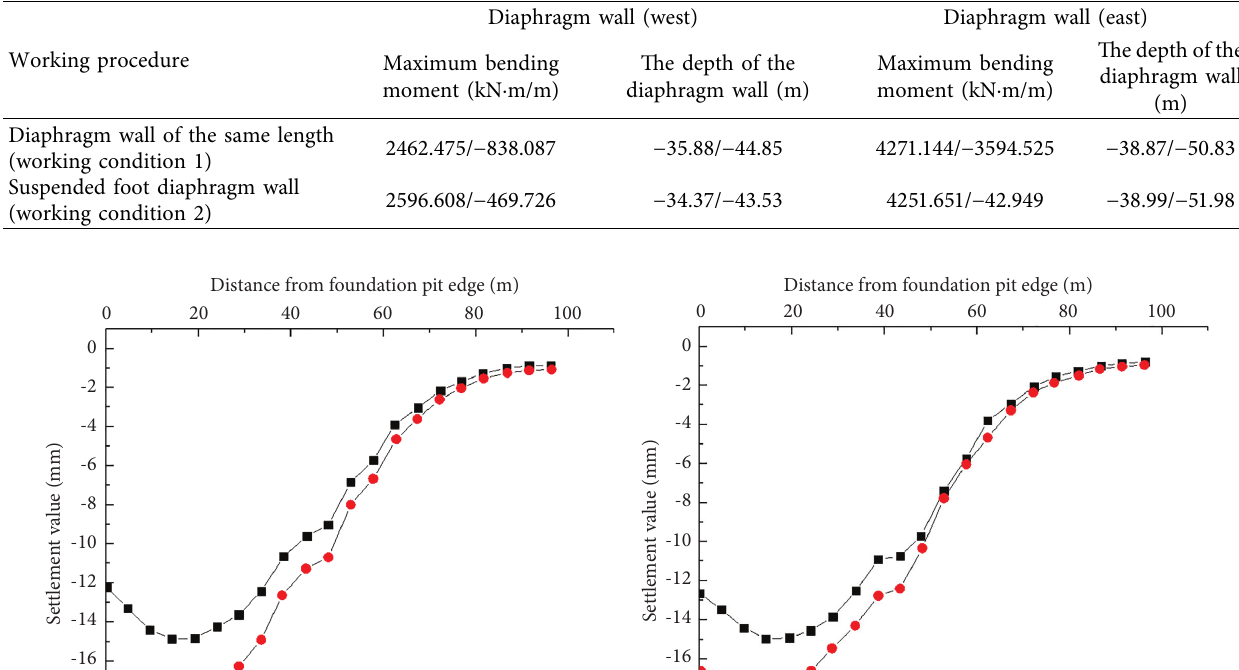
Table 11: The corresponding depth of maximum bending moment of diaphragm wall in the 10th excavation step under two working